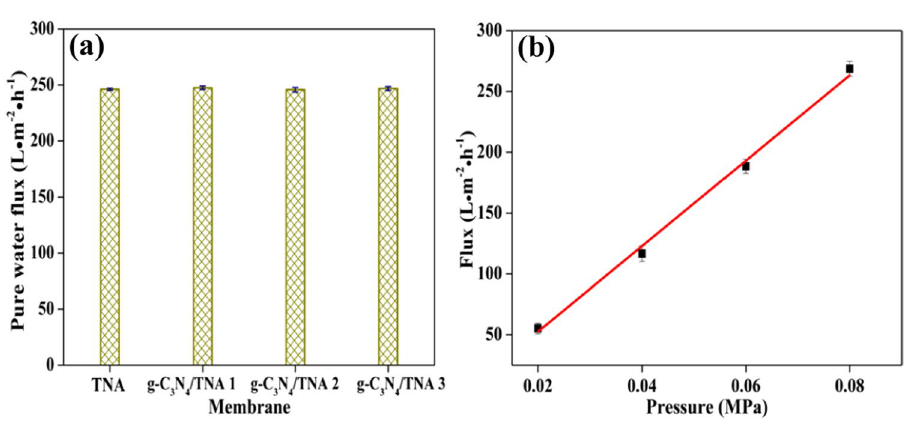
Figure 3. ( a ) Pure water flux (0.075 MPa) of TNA membrane, g-C 3 N 4 /TNA membrane 1, 2 and 3; ( b ) pure water flux of g-C 3 N 4 /TNA membrane 3 as a function of transmembrane